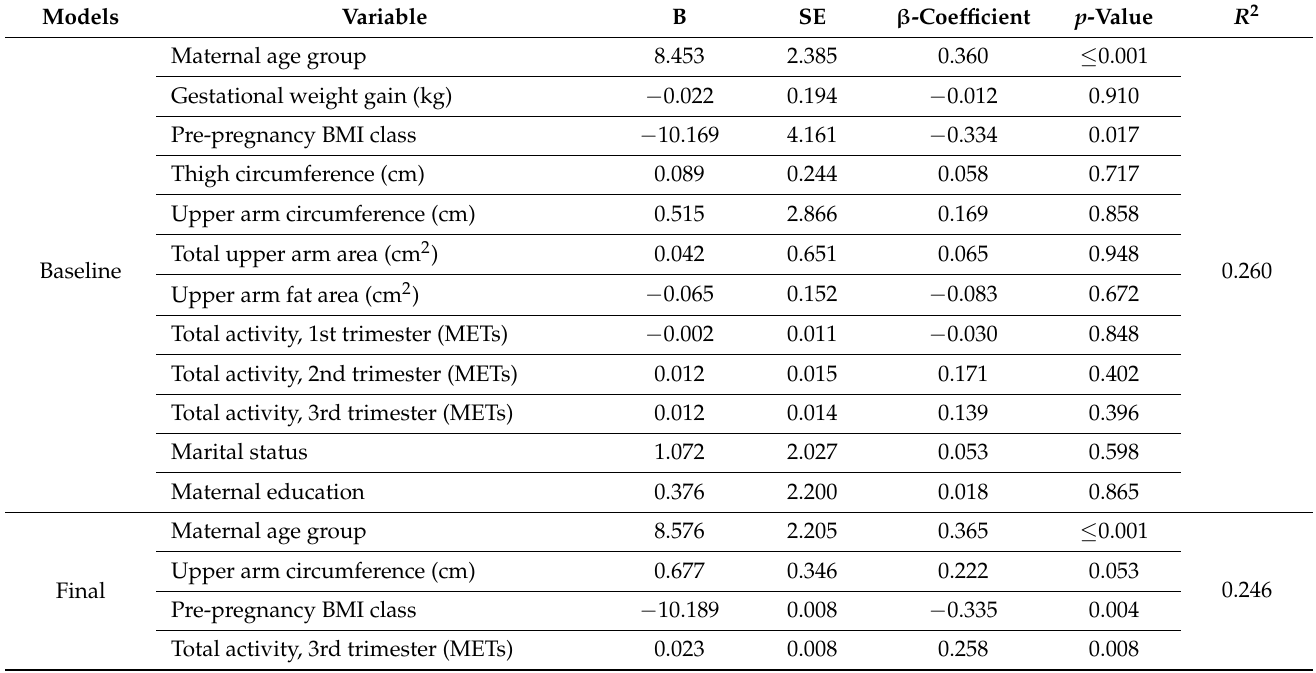
Table 4. Multiple linear regression: Diet quality (HEI, total) as an outcome variable (baseline and final model, n =